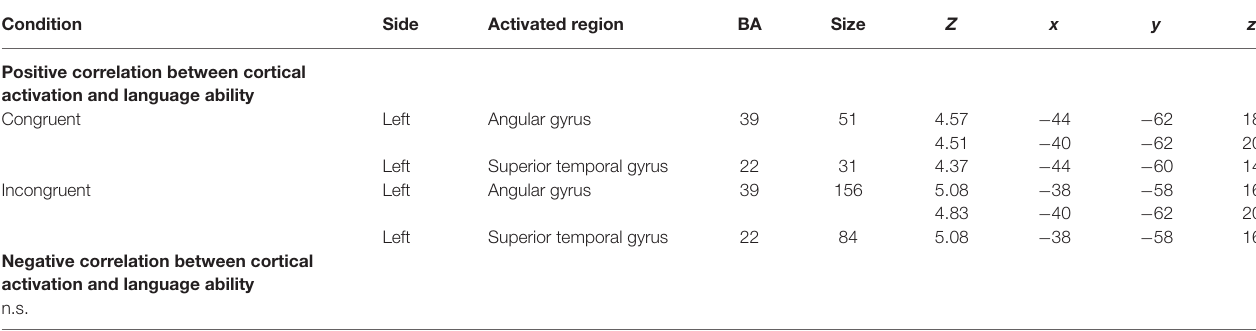
TABLE 2 | Regression analysis between high-level language ability and cortical activation. Condition Side Activated region Positive correlation between cortical activation and language ability Congruent